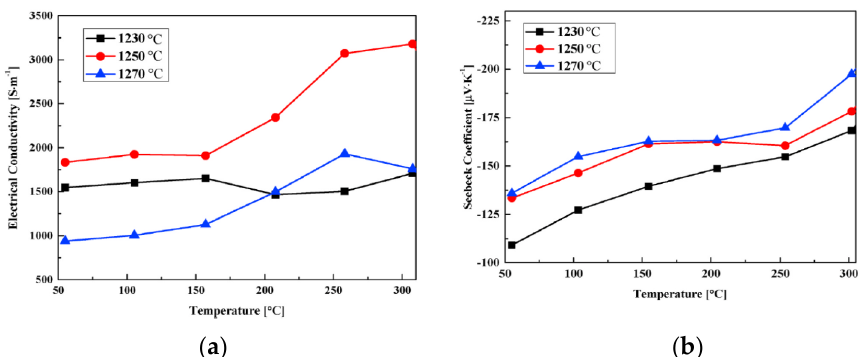
Figure 1. The electrical and thermoelectric properties of the Ni-doped ZnO made by thermal co- evaporation: ( a ) electrical conductivity, and ( b ) Seebeck coefficient. Reprinted with permission from [71], ©2020 Elsevier Ltd.